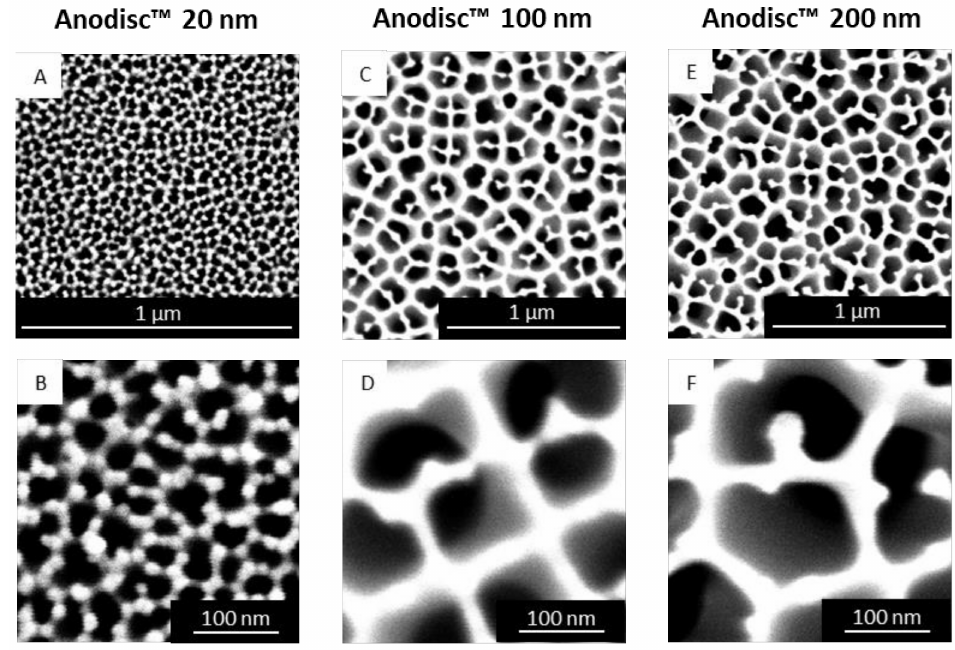
Figure 2. SEM images of representative Anodisc ™ membranes of 20 nm ( A , B ), 100 nm ( C , D ) and